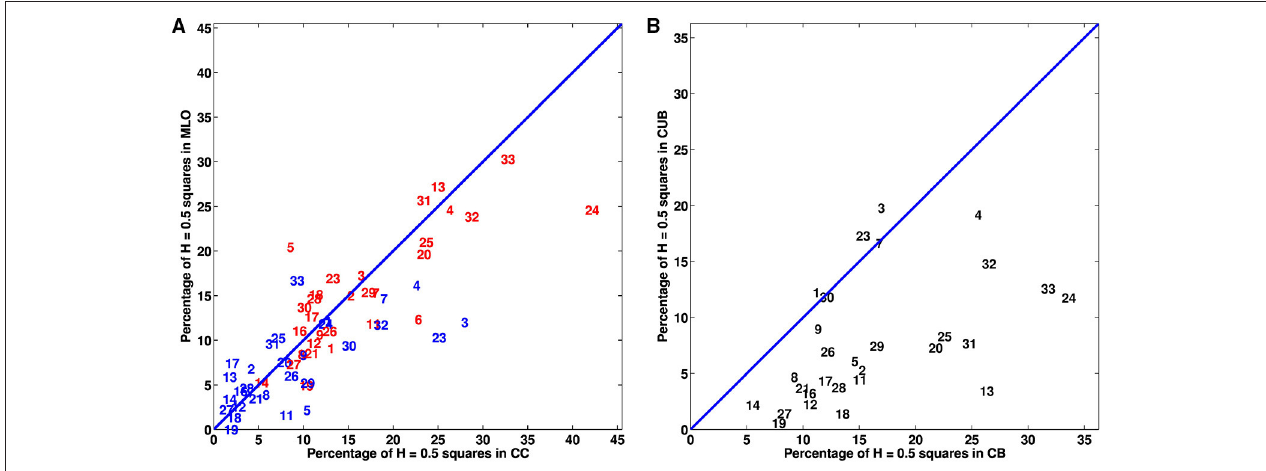
FIGURE 3 | Analysis of the percentage of monofractal uncorrelated H = 0.5 256 × 256 pixel 2 squares in the mammograms of the breasts of 30 patients with breast cancer. (A) Percentage of H = 0.5 squares in cancerous (red) and contralateral unaffected (blue) breasts: MLO view vs. CC view. (B) Mean percentage of H = 0.5 squares in MLO and CC views: contralateral unaffected breast (CUB) vs. cancerous breast (CB). In (A,B) , the numbers correspond to patient numbers defined in Table S1.